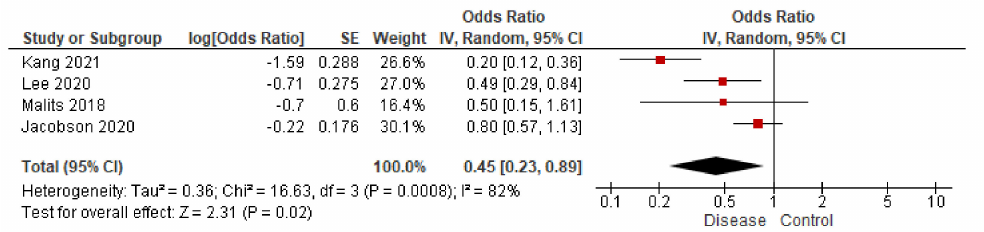
Figure 8. Study of the inverse variance in publications that determine the relationship between BPA and eGFR